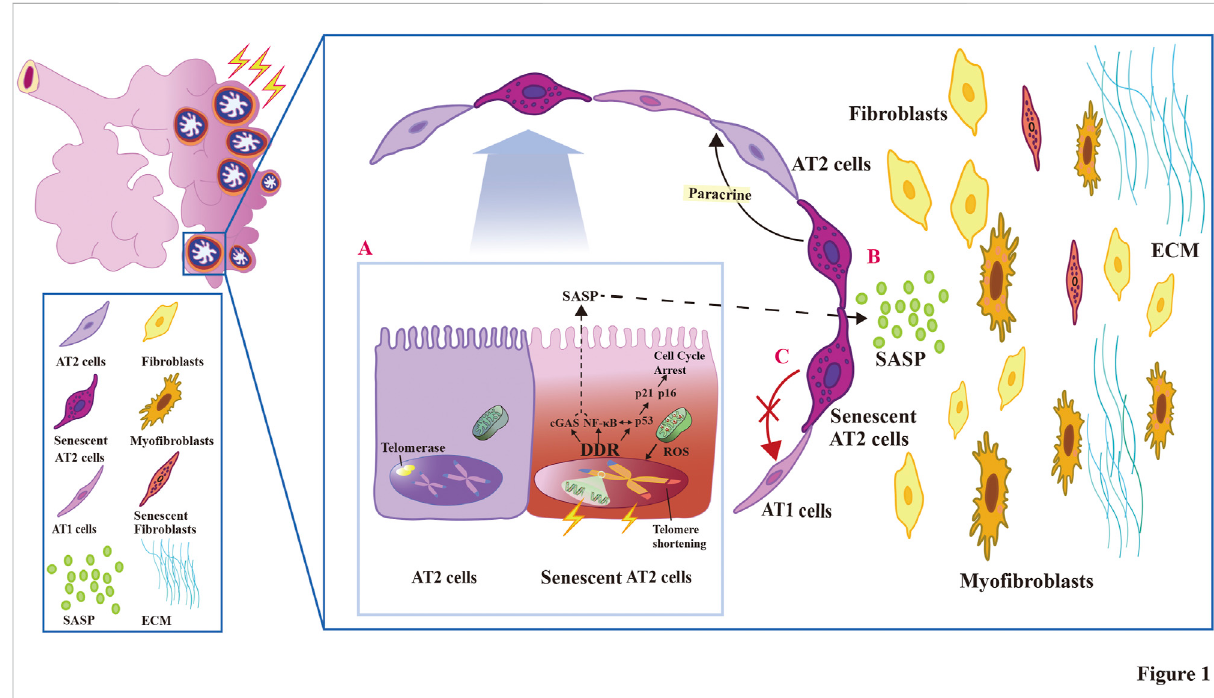
The relationship and pathogenesis associated with AT2 cell senescence and the development of fi brosis in RIPF.